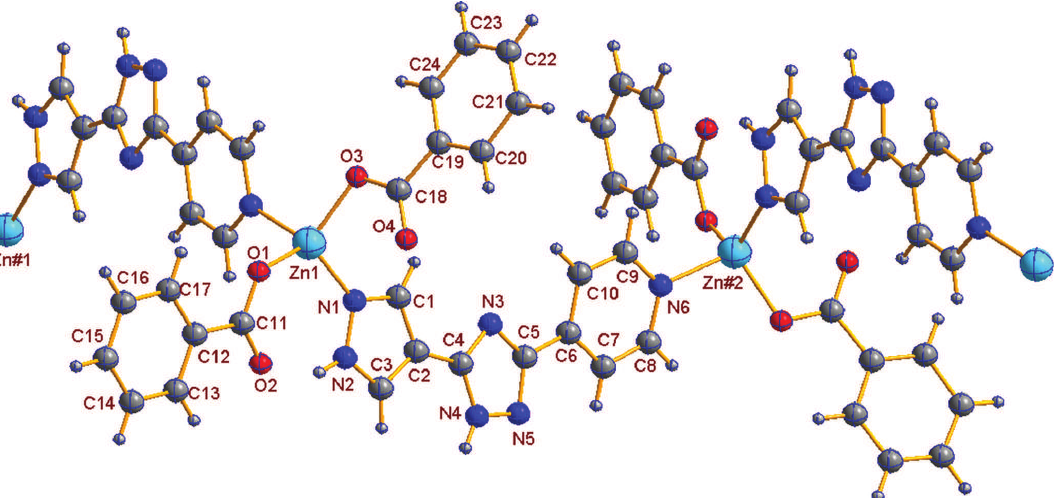
Table 1: Data collection and